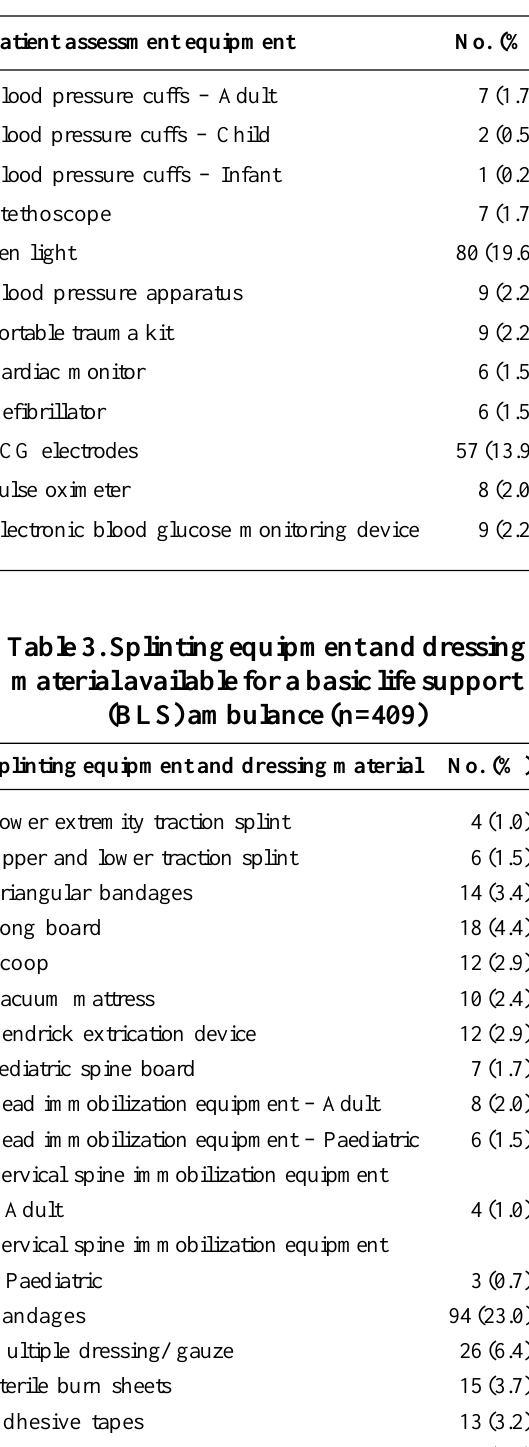
Table 2. Patient assessment equipment available for a basic life support (BLS)